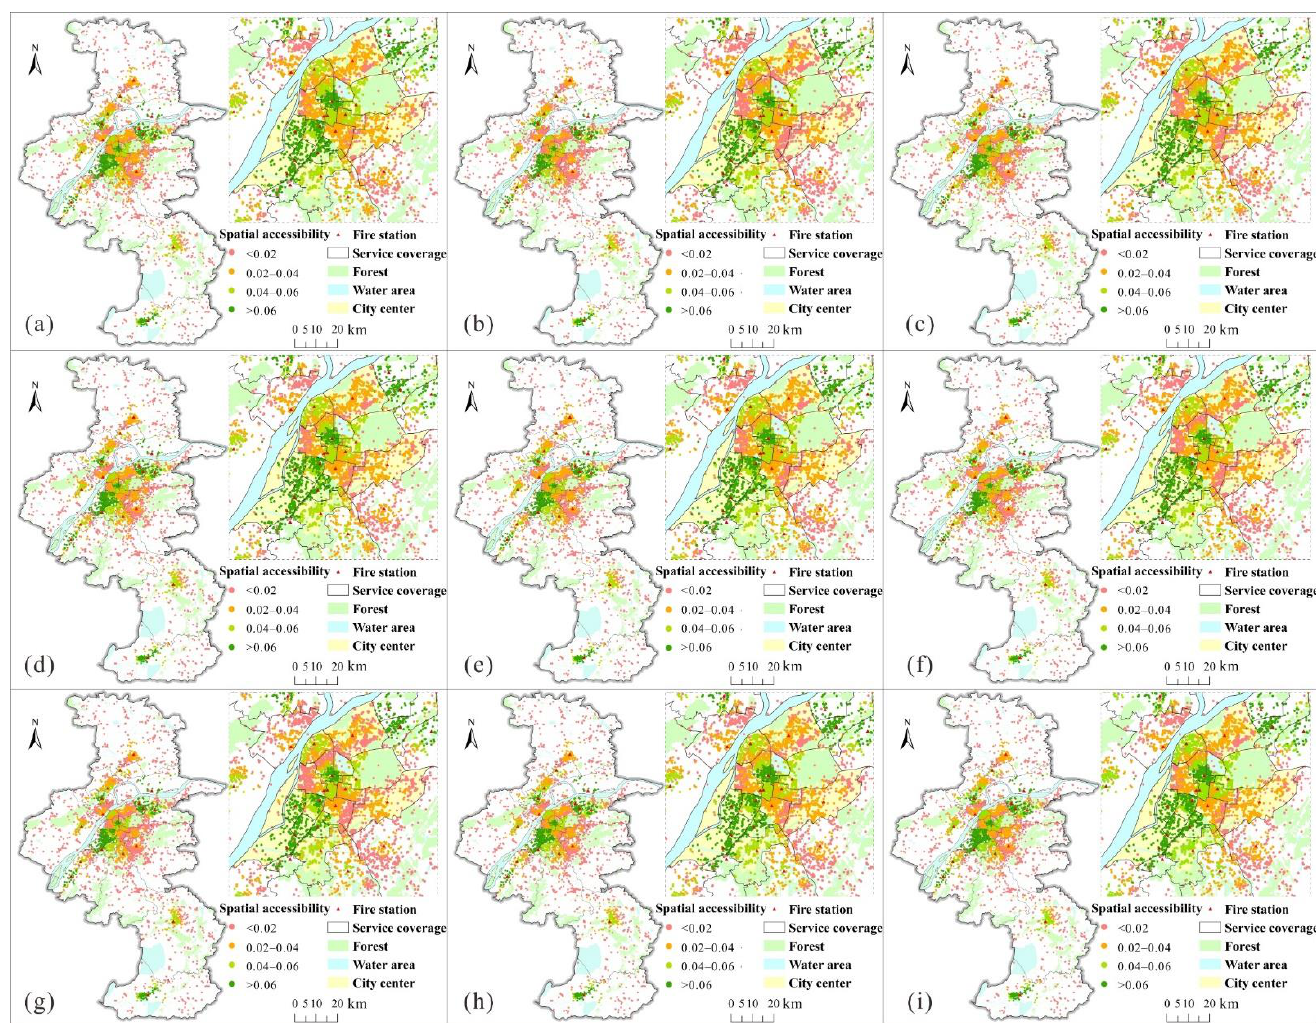
Figure 3. Spatiotemporal accessibility of fire incidents in Nanjing, China: ( a ) 05:00–07:00, ( b ) 07:00–09:00, ( c ) 09:00–11:00, ( d